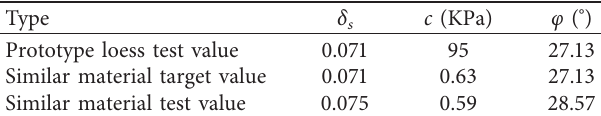
Figure 5: Intuitive analysis of the sensitivity of internal friction angle. Table 4: Mechanical parameters of prototype loess and similar